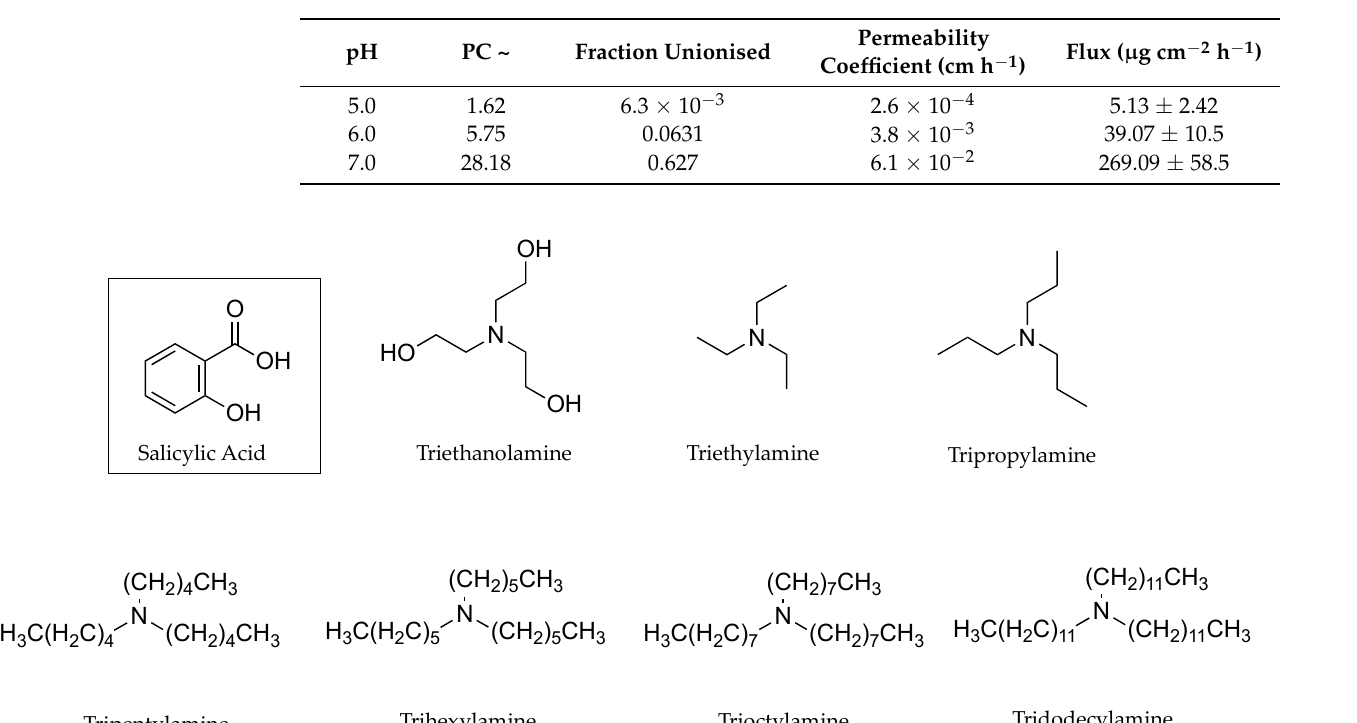
Table 5. Permeation parameters of DIC salts. According to the authors, saturated solutions were applied in permeation studies (for solubility and partition experiments, n = 3; for permeation exper- iments used to calculate permeation coefficient n ≥ 5; values represent the mean) Adapted from [32], MDPI, 2012. DIC Plus Counter Ion: